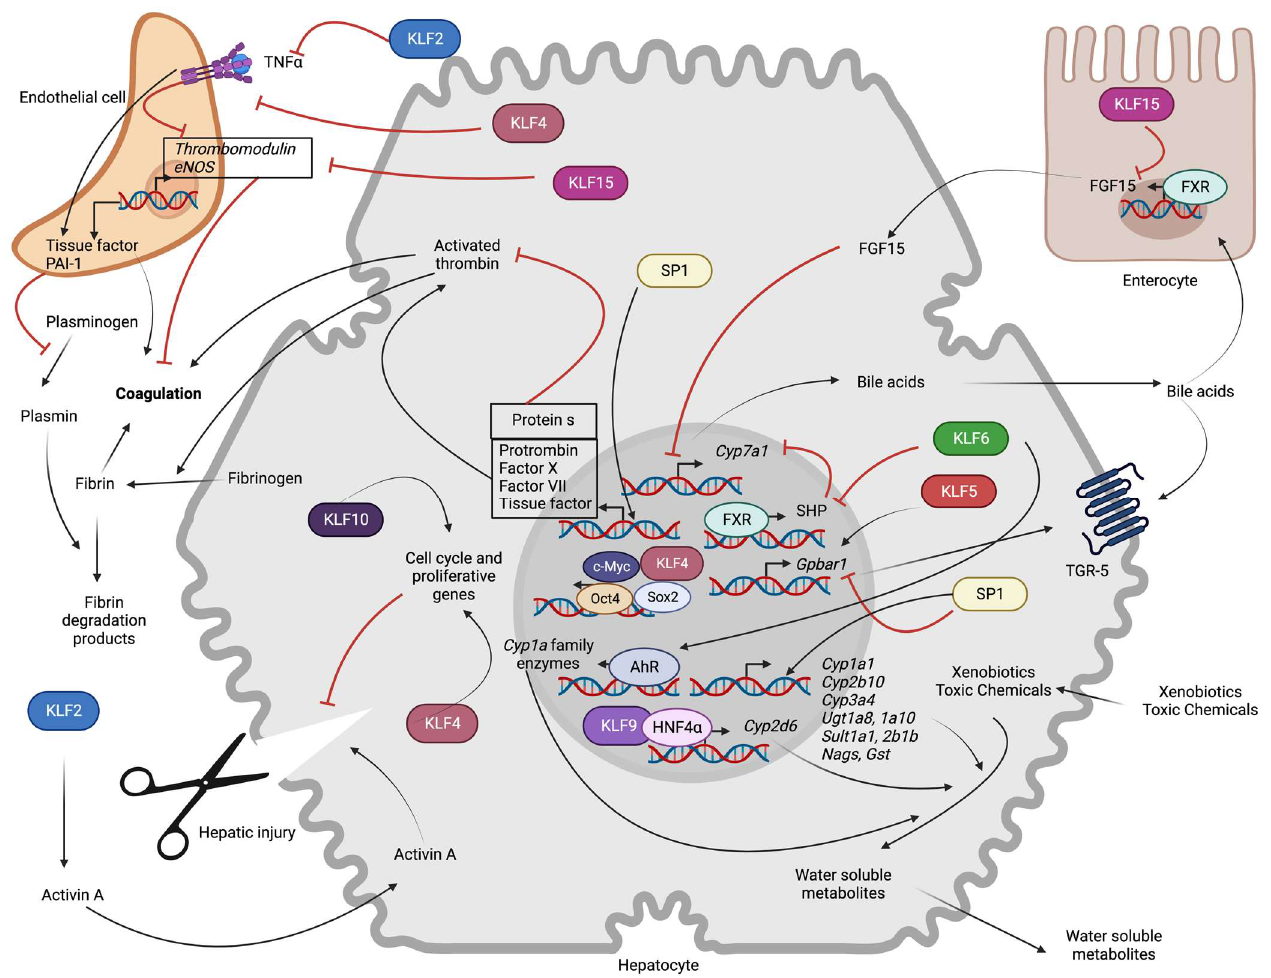
Figure 3. Role of hepatocyte SP/KLF transcription factors in non-metabolic functions: KLF6 indirectly increases expression of the rate-limiting enzyme for bile acid synthesis (Cyp7a1) by repressing FXR-mediated transcription of SHP. KLF15 indirectly promotes Cyp7a1 transcription via transcriptional repression of FGF15 expression in enterocytes. KLF5 enhances transcription of the Gpbar1 , whereas SP1 inhibits it. KLF6 promotes AhR-mediated transcription of the Cyp1a family, and KLF9 promotes HNF4α-mediated transcription of Cyp2d6. SP1 induces transcription of phase 1 (Cyp1a1, Cyp2b10, Cyp3a4) and phase 2 (Ugt1a8, Ugt1a10, Sult1a1, Sult2b1b, Nags, Gst) metabolic enzymes. SP1 also increases the transcription of clotting (Prothrombin, Factor X, Factor VII, TF) and anti-coagulation (Protein S) proteins. KLF2 and KLF4 prevent thrombosis and inflammation-induced prothrombotic gene (TF, PAI-1) expression and inhibitory influence on anti-thrombotic (TM, eNOS) gene expression. Endothelial KLF15 promotes thrombosis. In hepatocyte injury, endothelial KLF2 indirectly inhibits hepatic regeneration by leading to Activin A secretion. KLF4 and KLF10 promote hepatic regeneration by regulating the expression of cell cycle genes (AhR: Aryl hydrocarbon receptor, c-Myc: c-Myc